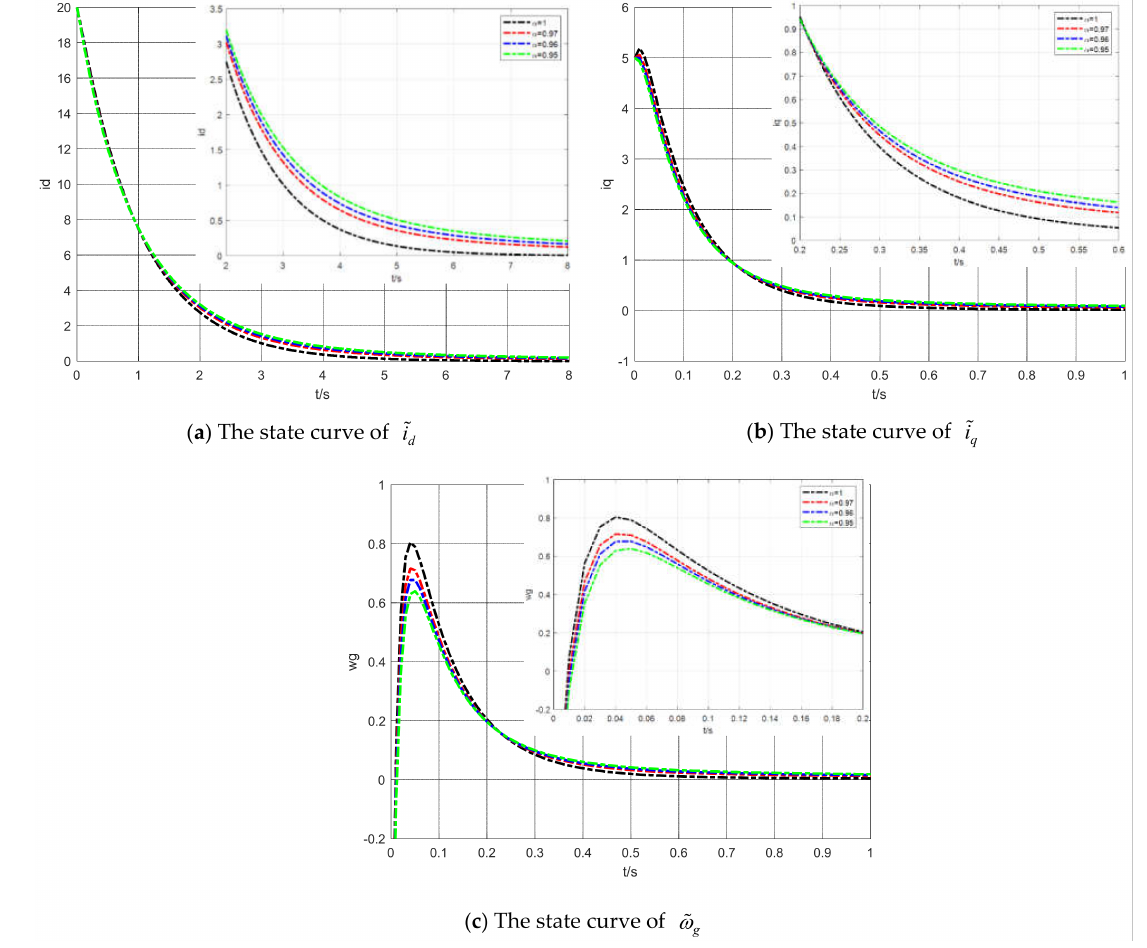
Figure 2. The control state diagram.